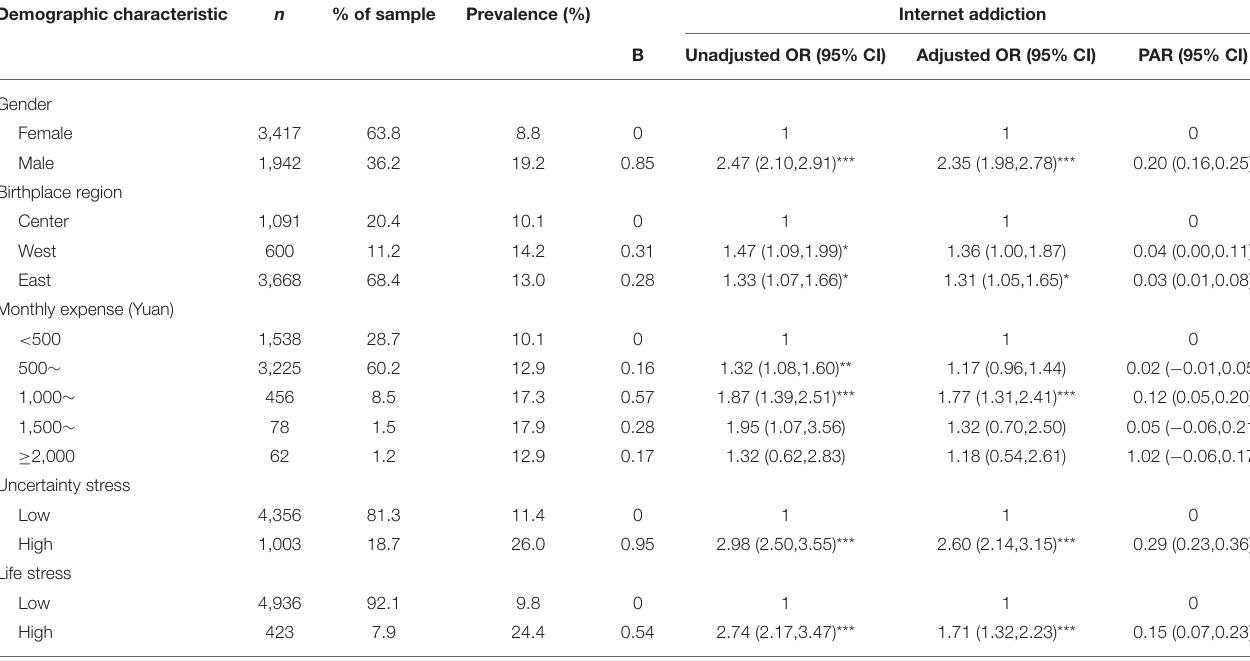
TABLE 2 | Multivariate logistic regression analysis of the odds of IA by stress type and selected sociodemographic characteristics, Chinese medical students ( N = 5,359). Demographic